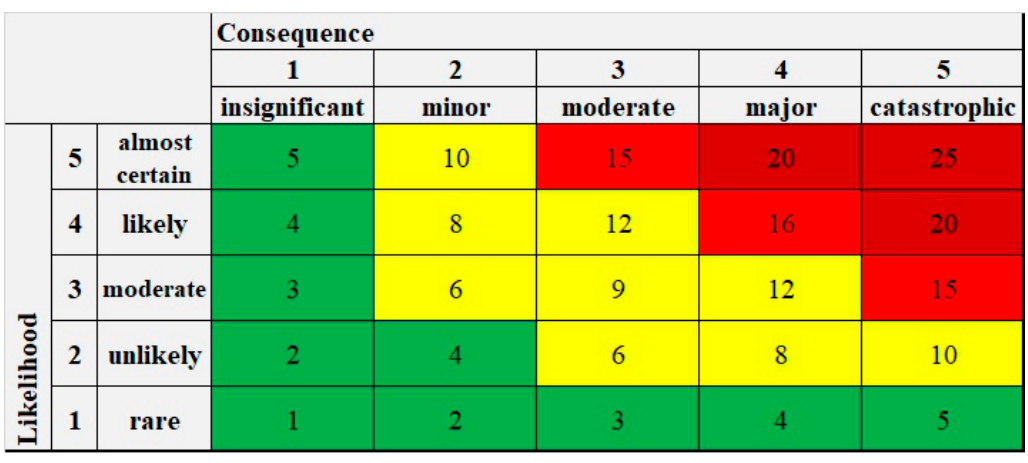
Figure 1. Risk (consequence/likelihood) matrix.